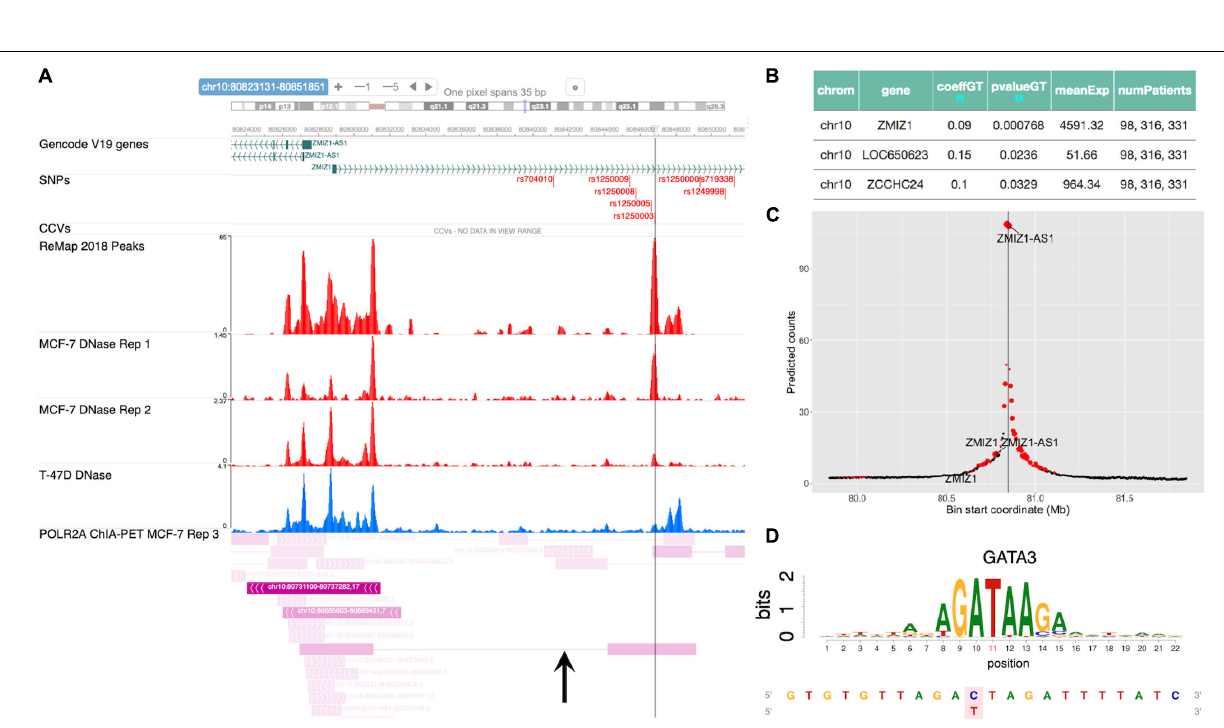
FIGURE 5 | Case study of GWAS locus at ZMIZ1 : (rs1250003, ZMIZ1 , GATA). (A) Embedded genome browser showing the LD SNP rs1250003 within an open chromatin region (MCF-7 DNase track) and several TF peaks (“ReMap 2018 Peaks”). Black arrow indicates a chromatin looping interaction between the SNP locus and the ZMIZ1 promoter. (B) eQTL results showing the top significant target gene of the GWAS SNP to be ZMIZ1 . (C) Average predicted chromatin contact counts across several HiC-Reg models in MCF-7, showing the ZMIZ1 promoter as one of the loci significantly interacting with the LD SNP. (D) Predicted TF candidate GATA motif from Kheradpour and Kellis